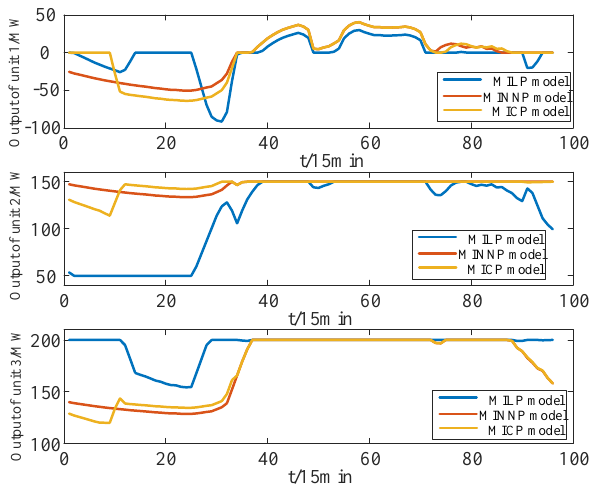
Energies 2019 , 12 , x FOR PEER REVIEW Figure 5. Optimal dispatch scheduling of units computed by three different SCUC models.